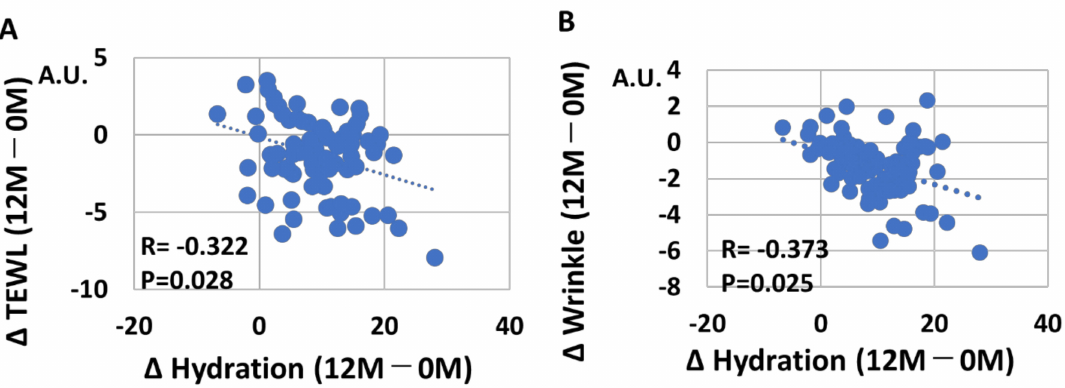
Figure 9. ( A ) Negative correlation ( p = 0.028) between ∆ skin hydration (12 M–0 M) and ∆ skin TEWL (12 M–0 M). ( B ) Negative correlation (p = 0.025) between ∆ skin hydration (12 M–0 M) and ∆ wrinkles (12 M–0 M).